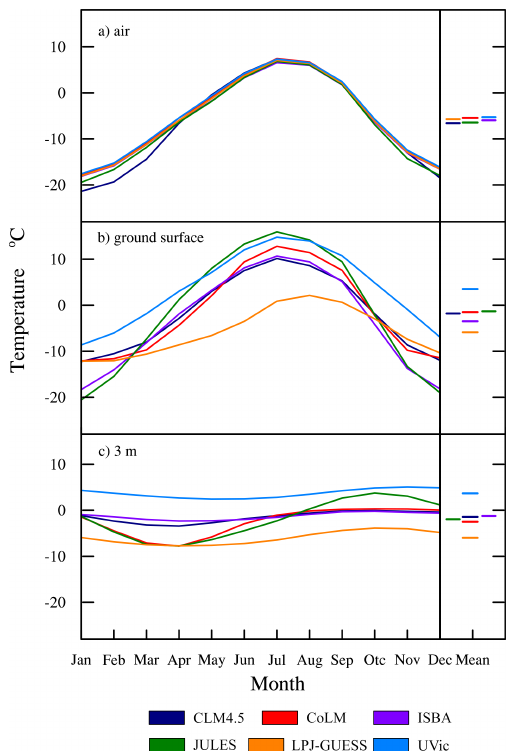
Figure 5. Monthly temperatures averaged over the selected western TP area in Fig. 1. (a) Forcing air temperature, (b) ground surface temperature, (c) 3m soil temperature, averaged over 1980–2000. “Mean” denotes annual average